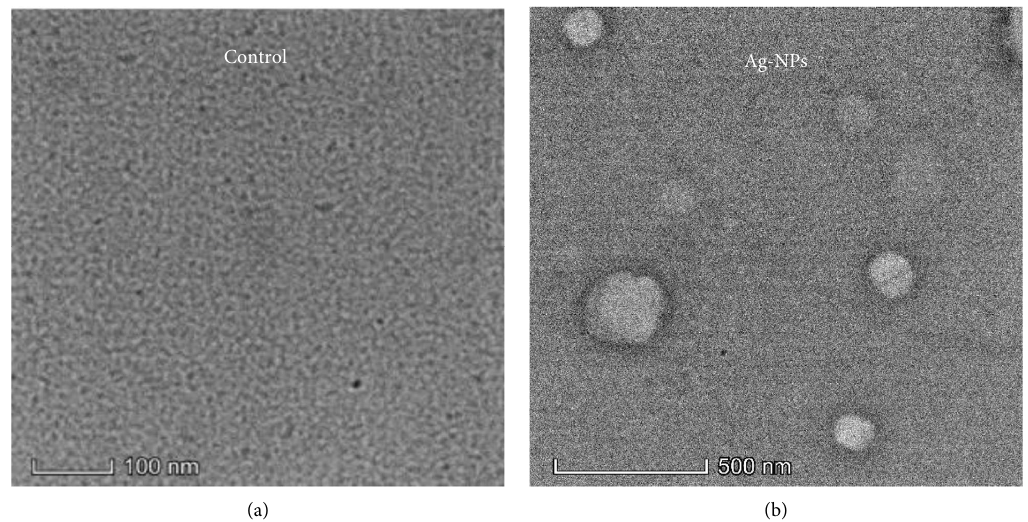
Figure 6: Te TEM images of yielded Ag-NPs: (a) control surface and (b) Ag-NPs coated